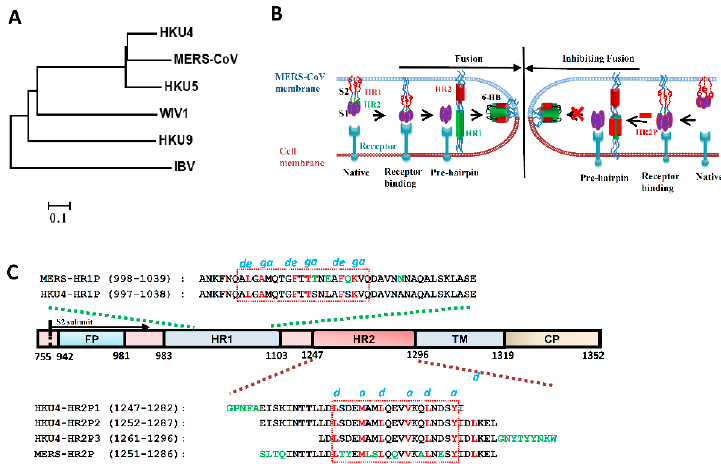
Figure 1. The design of HKU4 HR2-derived peptides. ( A ) Neighbor-joining tree created with the spike sequence of representative bat-CoVs and Infectious Bronchitis Virus (IBV). ( B ) The antiviral mechanism of HR2-derived peptides. ( C ) Schematic representation of HKU4 S protein S2 subunit. FP, fusion peptide; HR, heptad repeat domain; TM, transmembrane domain; CP, cytoplasmic domain. Corresponding sequences of the designed peptides (HKU4-HR1P and HKU4-HR2Ps) are shown in the diagram. The helical region in the HR1- and HR2-derived peptides is highlighted in the red boxes, according to the sequences of MERS-HR1P and MERS-HR2P. The identical amino acids at the e and g positions in HR1 and those at a and d positions in HR2 of MERS-CoV and HKU4 are highlighted in red. The different amino acids in HR1Ps and HR2Ps between MERS-CoV and HKU4 are highlighted in green.